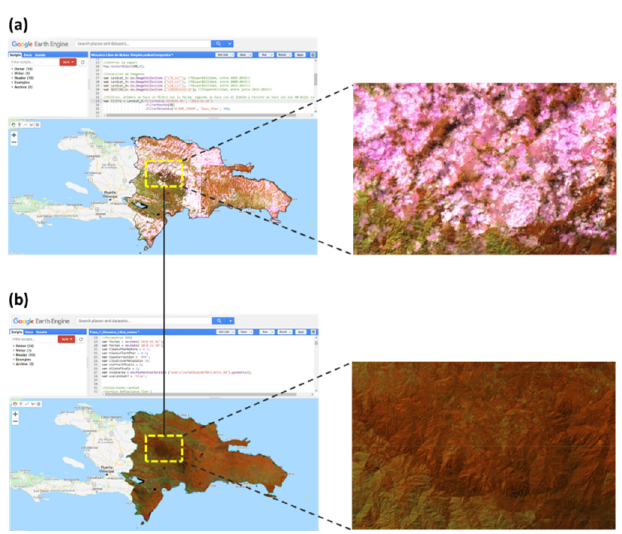
Figure 4. Mosaic of seasonal images for the Dominican Republic in 2018. ( a ) Original composite mosaic, ( b ) medoid composite (shortwave infrared 1 (SWIR1), near-infrared (NIR) and red band).